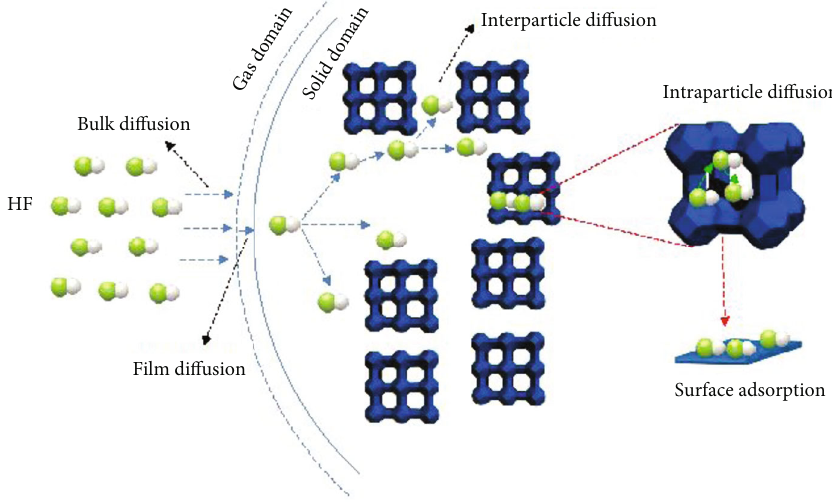
Figure 11: Adsorption mechanism of HF on 3A zeolite.